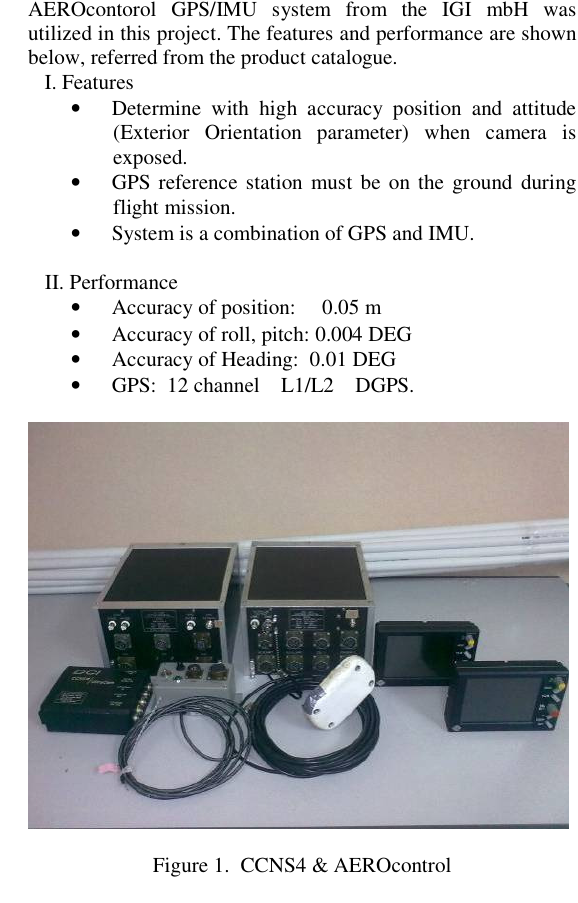
Figure 2. Flight plan of the boresight calibration Boresight calibration is the work of calculation misalignment with aerial camera and IMU. This work is conducted to determine the value of its correction by comparing the exterior orientation parameters from aerial triangulation and direct geo-